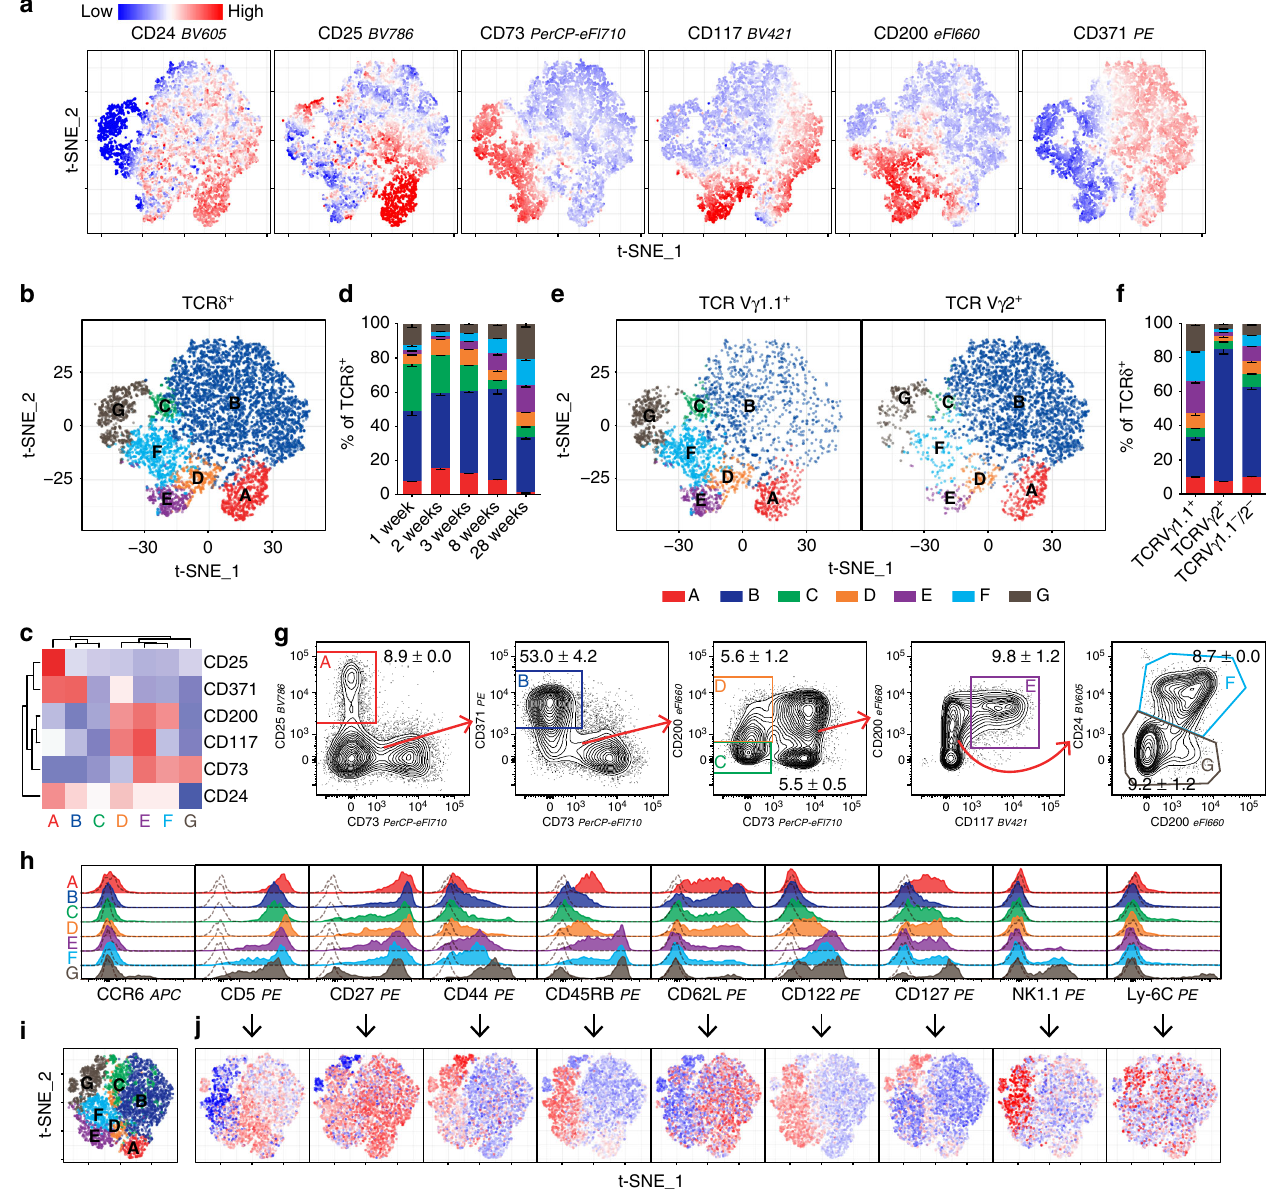
Fig. 2 Surface expression of CD117, CD200 and CD371 allows the isolation of seven distinct γδ thymocyte populations a , b t-SNE map of TCR δ + thymocytes coloured by a normalised expression intensities of CD24, CD25, CD73, CD117, CD200 and CD371 or by b FlowSOM automated clustering. Based on fl ow cytometric analysis of 2 × 5000 TCR δ + cells pooled from two mice in silico. c Heat map of mean expression intensity of markers within the FlowSOM clusters named A to G. d Distribution of cells within populations A to G shown as a percent of the total TCR δ + thymocytes from 1- to 28-week- old mice. Bars depict the mean ± SEM ( n = 4, 4, 4, 2, 3 mice). e , f Distribution of cells within populations A to G within the V γ 1.1 + and V γ 2 + subsets of TCR δ + thymocytes visualised as e t-SNE map coloured by FlowSOM clusters as in b , f stacked bar plots. Bars depict the mean ± SEM ( n = 2 mice). g Standard bi-axial TCR δ + gating of population A to G. Numbers denote the mean ± SEM of total TCR δ + thymocytes ( n = 2 mice). h , i , j Expression of established surface markers of γδ T cells within populations A to G visualised as h representative histograms or i , j representative t-SNE maps ( n = 6 mice). h Dashed lines show background signal by FMO. i , j Colours depict i the location of events assigned to populations A to G within the t-SNE plot or j the normalised expression intensity of each